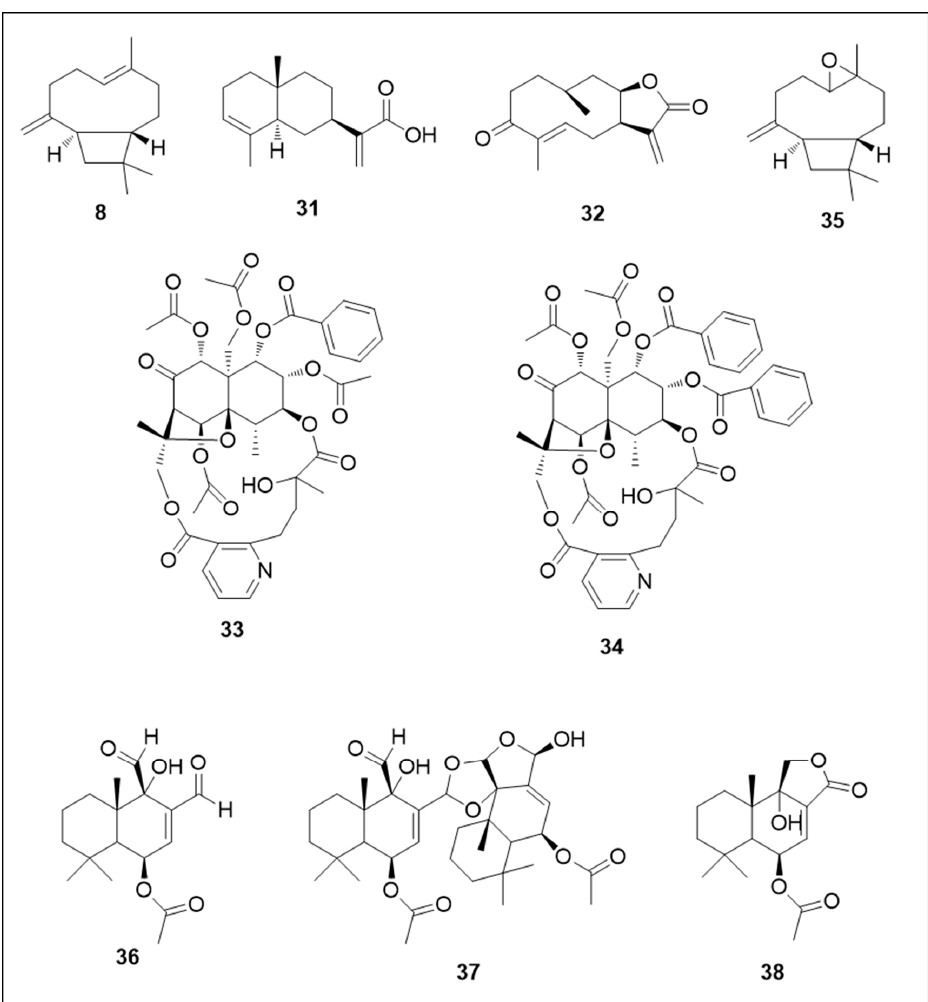
Figure 6. Sesquiterpenes active against Ae. aegypti .